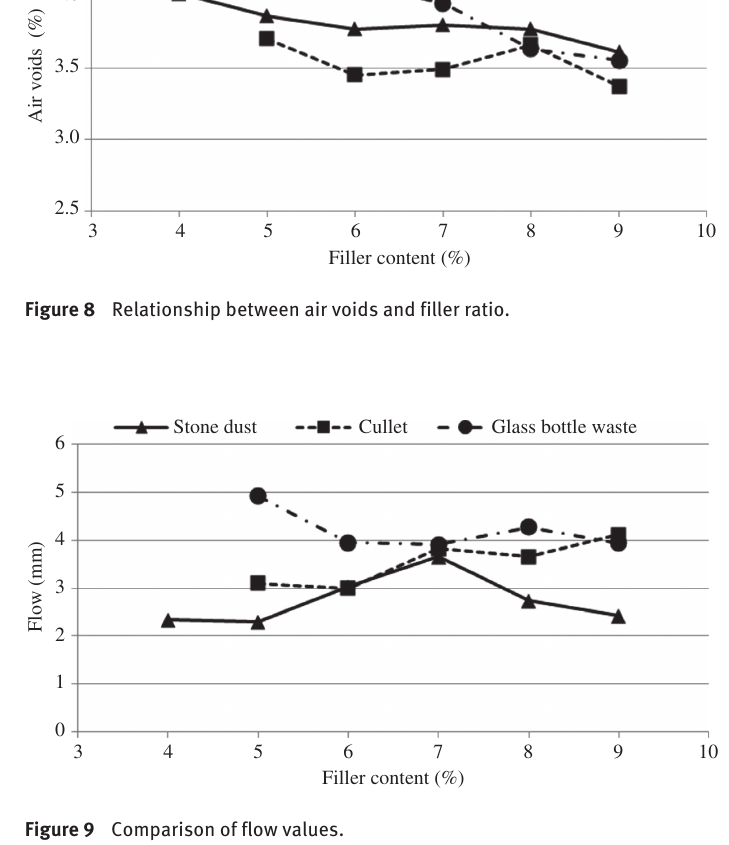
Figure 9 Comparison of flow